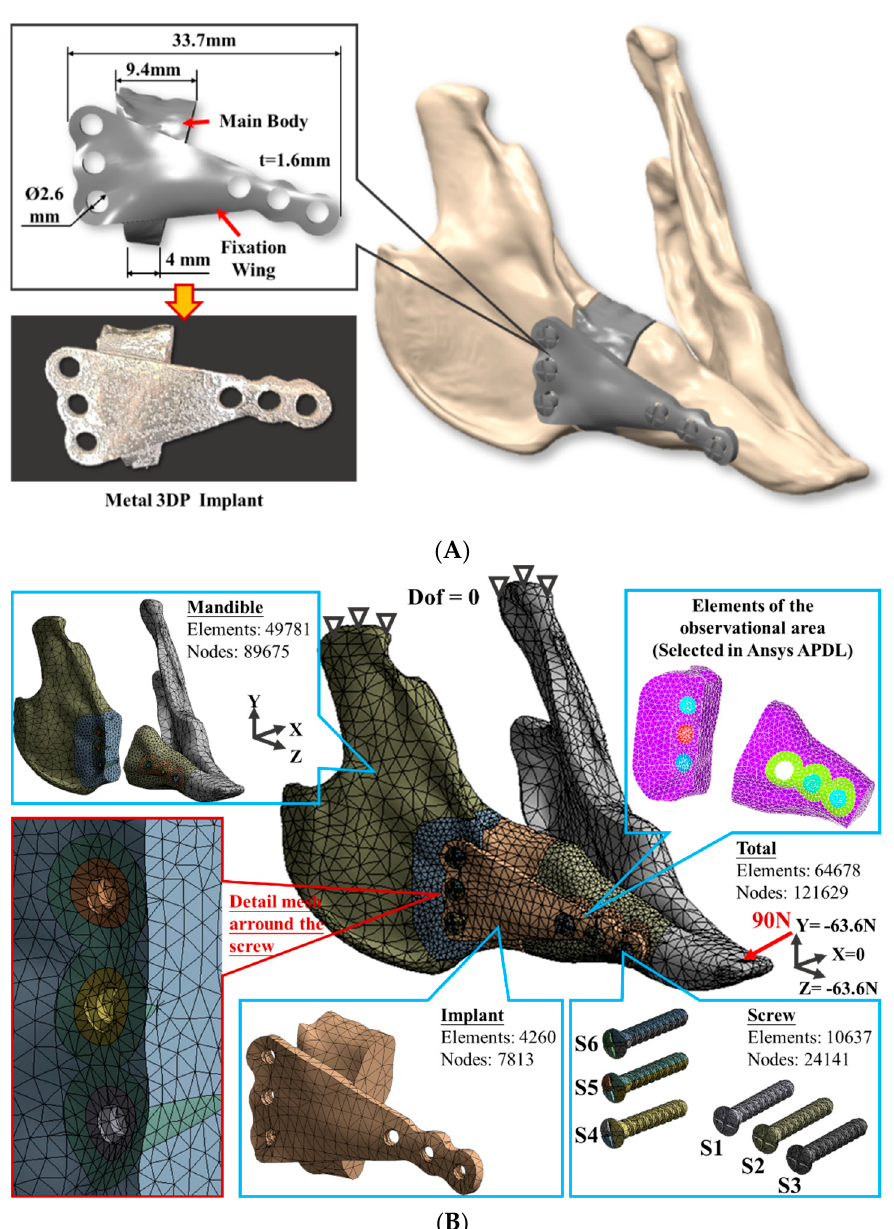
Figure 1. ( A ) Solid model of the rabbit mandible with unilateral defect at the right posterior teeth area and placed with a specific reconstruction implant; ( B ) FE (finite element) mesh model of simulated mandible with reconstruction implant and fixation screw (S4, S5, and S6 at distal side and S1, S2, and S3 at mesial side) and detailed mesh pattern around the fixation screws.